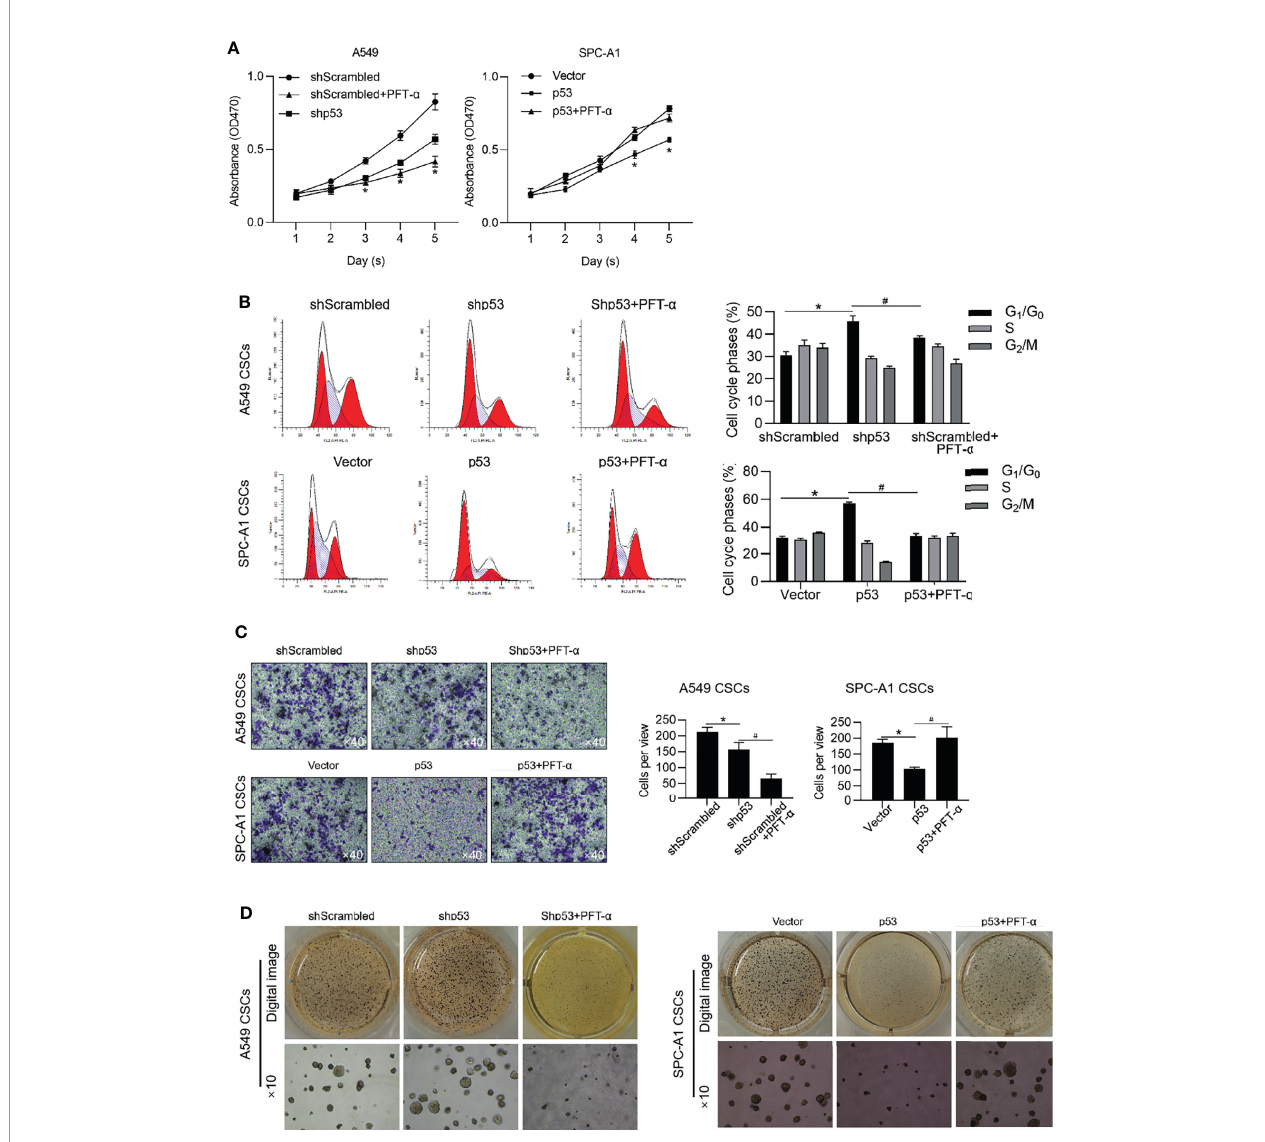
FIGURE 7 | p53 inhibits malignancies via exerting transcriptional activity. In A549 CSCs, p53 was ef fi ciently knockdown by transfecting shRNA targeting to p53 mRNA. In PC-9 CSCs, p53 was ef fi ciently overexpressed by transfecting p53-coding plasmid. Cell viability was then analyzed by performing CCK-8 assay (A) . * p < 0.05 vs. shScrambled group (left panel); * p < 0.05 vs. vector group (right panel). (B) Cell cycle distribution was analyzed by performing PI staining followed by fl ow cytometry assay. * p < 0.05 vs. shScrambled group; # p < 0.05 vs. shp53 group (left panel); * p < 0.05 vs. vector group; # p < 0.05 vs. p53 group (right panel). (C) Cell invasion was analyzed by performing Transwell assay. * p <0.05 vs. shScrambled group; # p < 0.05, vs. shp53 group (left panel); * p < 0.05, vs. vector group; # p < 0.05 vs. p53 group (right panel). (D) Tumor formation in soft agar was performed. * p < 0.05 vs. shScrambled group; # p < 0.05 vs. shp53 group (left panel); * p < 0.05 vs. vector group; # p < 0.05 vs. p53 group (right